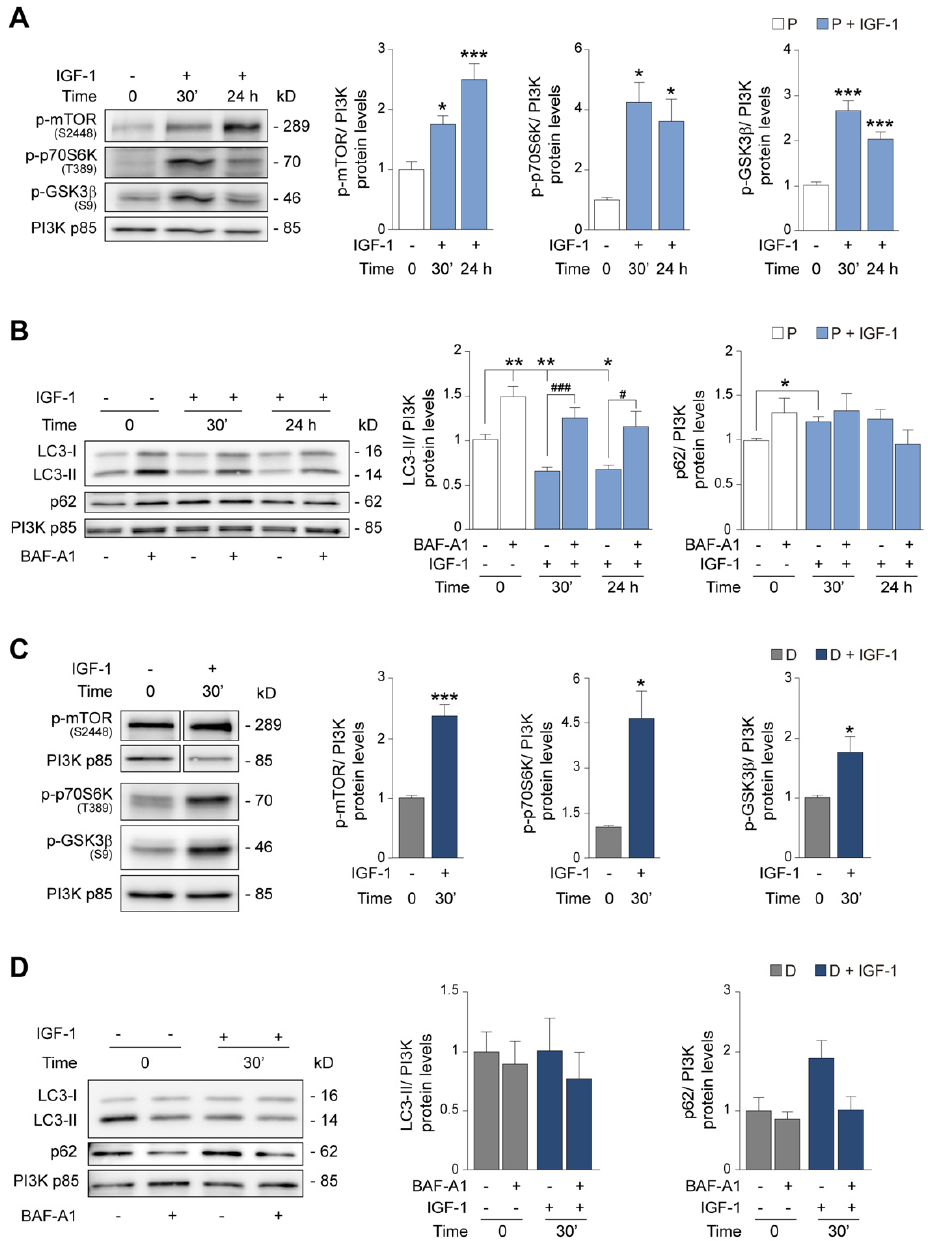
Figure 4 . IGF − 1 stimulates anabolism and reduces autophagic flux in HEI − OC1 progenitor cells . ( A ) HEI − OC1 P cells were cultured as shown in Figure 3A and left untreated (white bars) or treated (light blue bars) with IGF − 1 (10 nM) for 30 min or 24 h and then lysed for the immunodetection of p − mTOR (Ser2448), p − p70S6K (Thr389) and p − GSK3 β (Ser9). ( B ) HEI − OC1 P cells were starved for 24 h and left untreated (white bars) or treated (light blue bars) with IGF − 1 (10 nM) for 30 min or 24 h, BAF − A1 (100 nM) for 6 h, or a combination of both, as indicated. Cells were lysed, and LC3 − II and p62 levels were analyzed by Western blotting. Representative immunoblots from at least n = 3 independent experiments are shown. PI3K p85 was used as a loading control. Data are expressed as mean ± SEM. Statistical significance was determined using one − way ANOVA: * p < 0.05, ** p < 0.01 and *** p < 0.001 versus control (0 h); # p < 0.05 and ### p < 0.001 versus IGF − 1 at the same experimental time. ( C ) HEI − OC1 D cells were cultured as shown in Figure 3A and left untreated (gray bars) or treated (dark blue bars) with IGF − 1 (10 nM) for 30 min and lysed for the immunodetection of p − mTOR (Ser2448), p − p70S6K (Thr389) and p − GSK3 β (Ser9). ( D ) HEI − OC1 D cells were starved for 24 h and left untreated (gray bars) or treated (dark blue bars) with IGF − 1 (10 nM) for 30 min, BAF − A1 (100 nM) for 6 h, or a combination of both, as indicated. Cells were lysed, and LC3 − II and p62 levels were analyzed by Western blotting. Representative immunoblots from at least n = 4